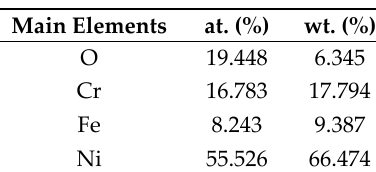
Figure 18. SEM images surface around the D top of hole No. 3. Materials 2020 , 13 , x FOR PEER REVIEW